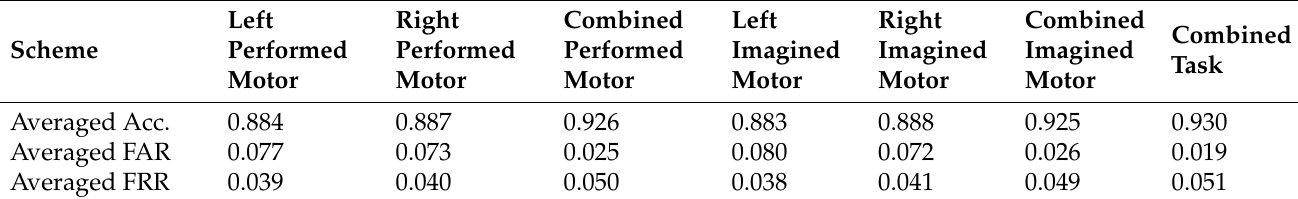
Table 1. Results averaged over subjects and folds of the left or right arm and combined motor tasks.